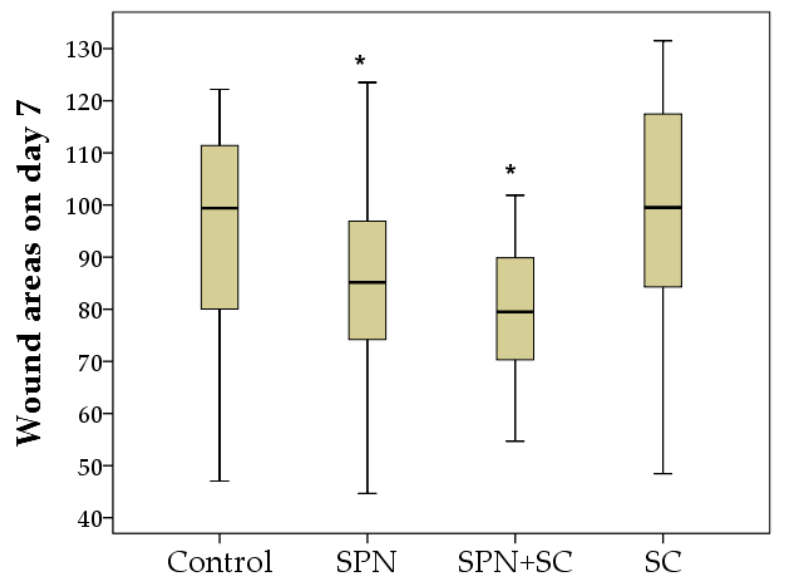
Figure 5. Wound areas on day 7 of the study in different groups (mm 2 ). Notes: *—difference from the control group at p < 0.05. Post hoc analysis score (Dunnett’s T-test for comparison with a control group). Data are presented as median and interquartile range.